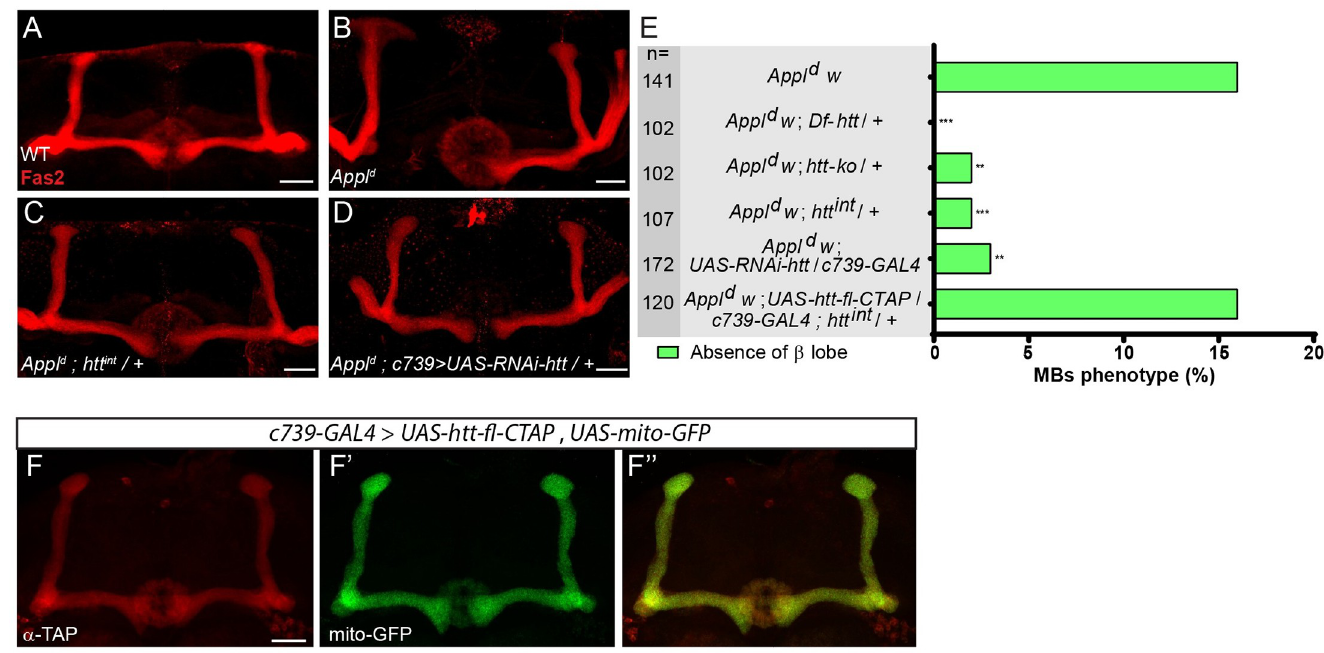
Fig 1. The loss of htt rescues the Appl d MB axon outgrowth mutant phenotype. (A) Wild-type MB α and β lobes revealed by anti-Fas2 staining. (B-D) Anti-Fas2 staining reveals the absence of the β lobe in an Appl d mutant brain (B), which is rescued by the loss of one copy of htt (C) and is also rescued by the expression of RNAi against htt driven by c739-GAL4 (D). (E) Quantitation of rescue of the MB Appl d phenotype by Df-htt , htt-ko , htt int and UAS-RNAi-htt driven by c739-GAL4 . The rescue of Appl d by htt int is prevented by the overexpression of htt driven by c739-GAL4 indicating the functionality of the UAS-htt-fl-CTAP transgene. n = number of MBs analyzed, �� P < 0.01 and ��� P < 0.001. Significance was calculated by a multiple comparison Fisher’s exact test (P = 5.8 10 − 10 ) followed by post-hoc Bonferroni’s multiple comparison correction (p-values = 2.3 10 − 5 , 0.0018, 0.0009, 0.0014 and 1). (F-F”) The expression of UAS-htt-fl-CTAP revealed by an anti-TAP staining (F) and UAS-mito-GFP (F’) driven by c739-GAL4 are similar in the MBs (F”). All panels correspond to adult brains. The scale bar on panels A-D and F indicates 30 μ m. Images are composite stacks to allow the visualization of axon trajectories along their entire length. Full genotypes: (A) y w 67c23 / Y; c739-GAL4 UAS-mito-GFP / + .